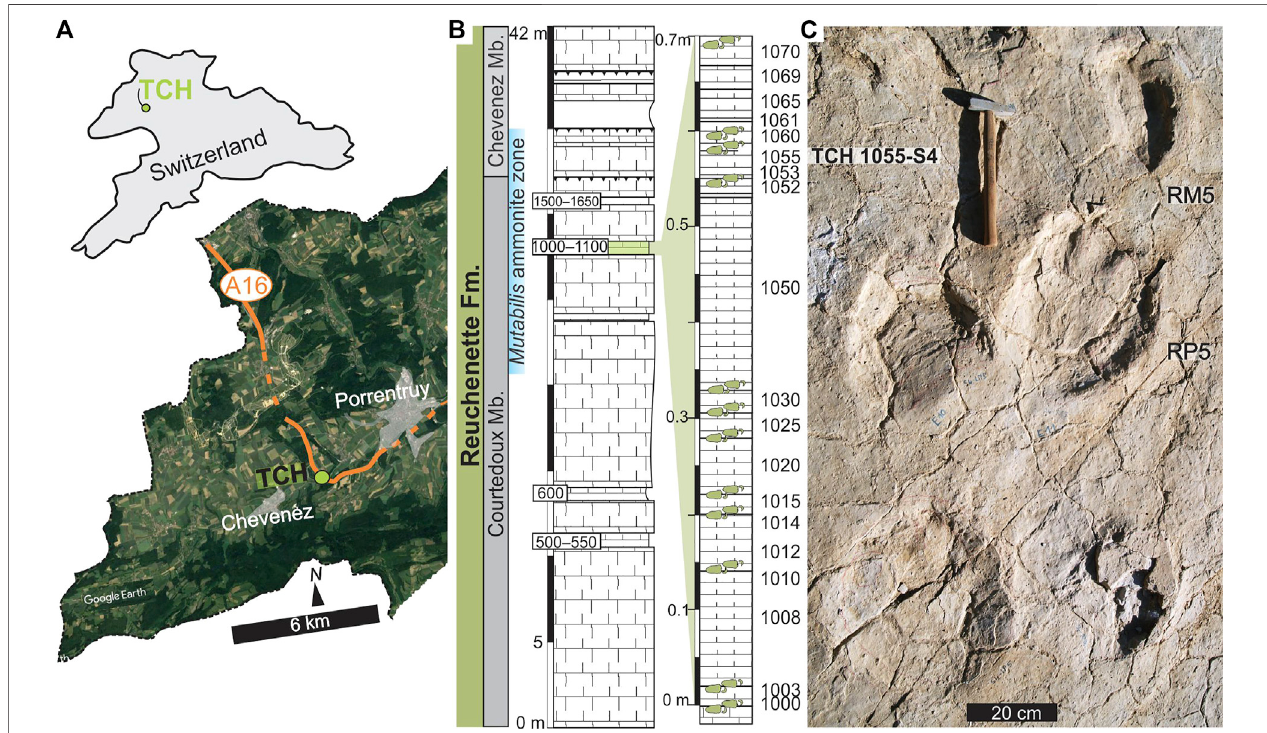
FIGURE 1 | (A) Courtedoux-Tchâfouè tracksite (TCH) tracksite (NW Switzerland; 47 ° 24 ′ 13.7 ″ N 7 ° 01 ′ 21.6 ″ E). (B) Lithostratigraphy of the Reuchenette Formation with emphasis on the biolaminate horizons bearing sauropod tracks/trackways (level numbers in boxes). The TCH track-bearing biolaminate levels of this study are shown to the right and numbered sequentially (levels 1000 – 1070 and indicated with green track symbols). (C) Section of trackway 1055-S4 from Level 1055.